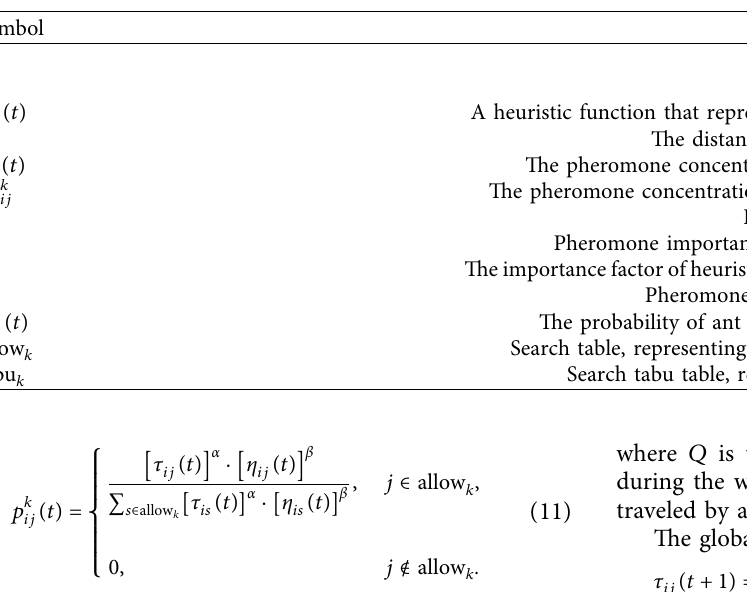
Table 4: Constants and variables in ant colony algorithm.